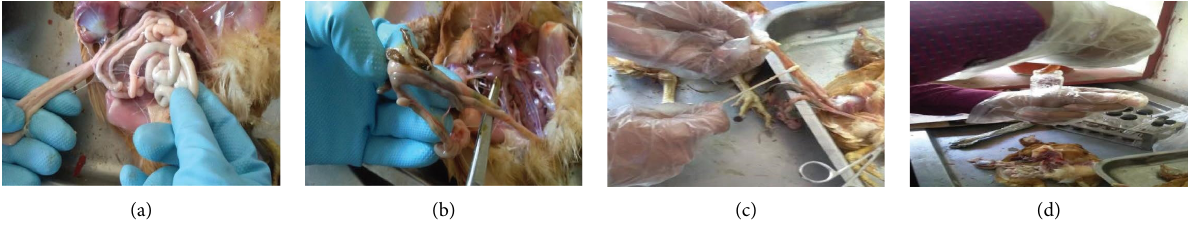
Figure 1: Postmortem examinations of chickens revealed the presence of intestinal lesions like (a) intestine balloons with gas, (b) ulceration, (c) collection of swab samples, and (d) intestinal contents for the isolation and identifcation of C. perfringens . Table 1: Oligonucleotide primer sequences and amplifed PCR product sizes were used for the detection of C. perfringens and its toxin genes. Name of bacteria